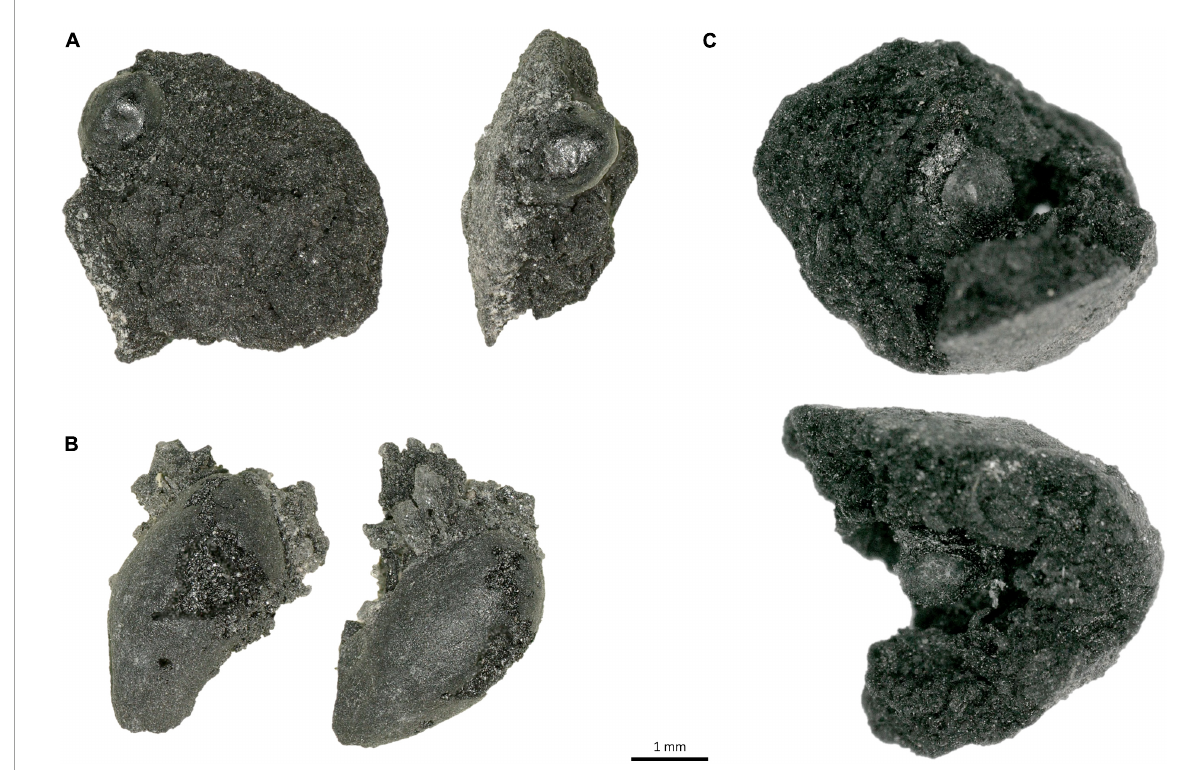
FIGURE9 Three examples of sheep/goat dung with an embedded seed: (A–C) present two views of each